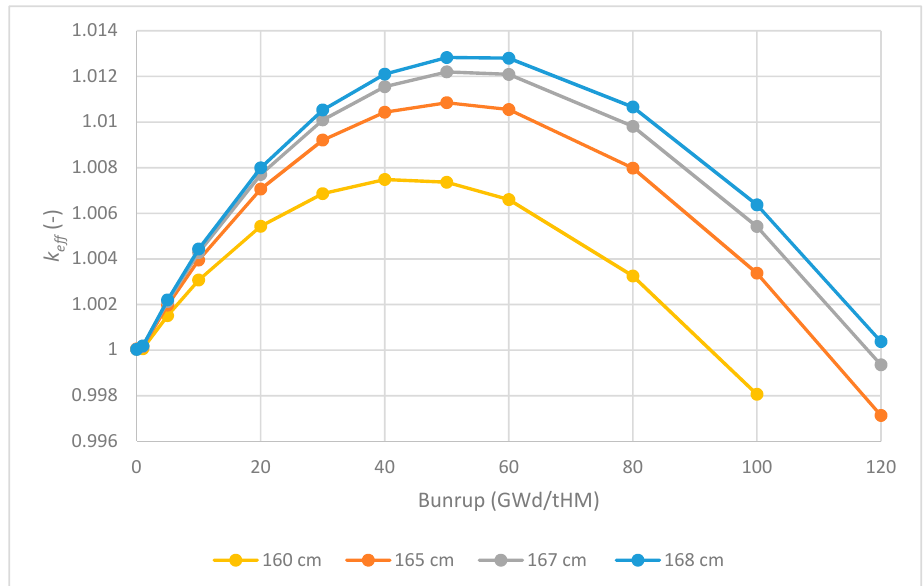
Table 5. Data (initial criticality and required uranium 235 enrichment) for the dimensional iteration for the averaged fuel temperature of 930 K for the heavy metal rich system.